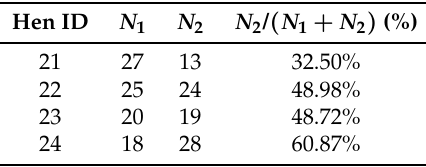
Table 2. Number of visiting times of nest box for the individual